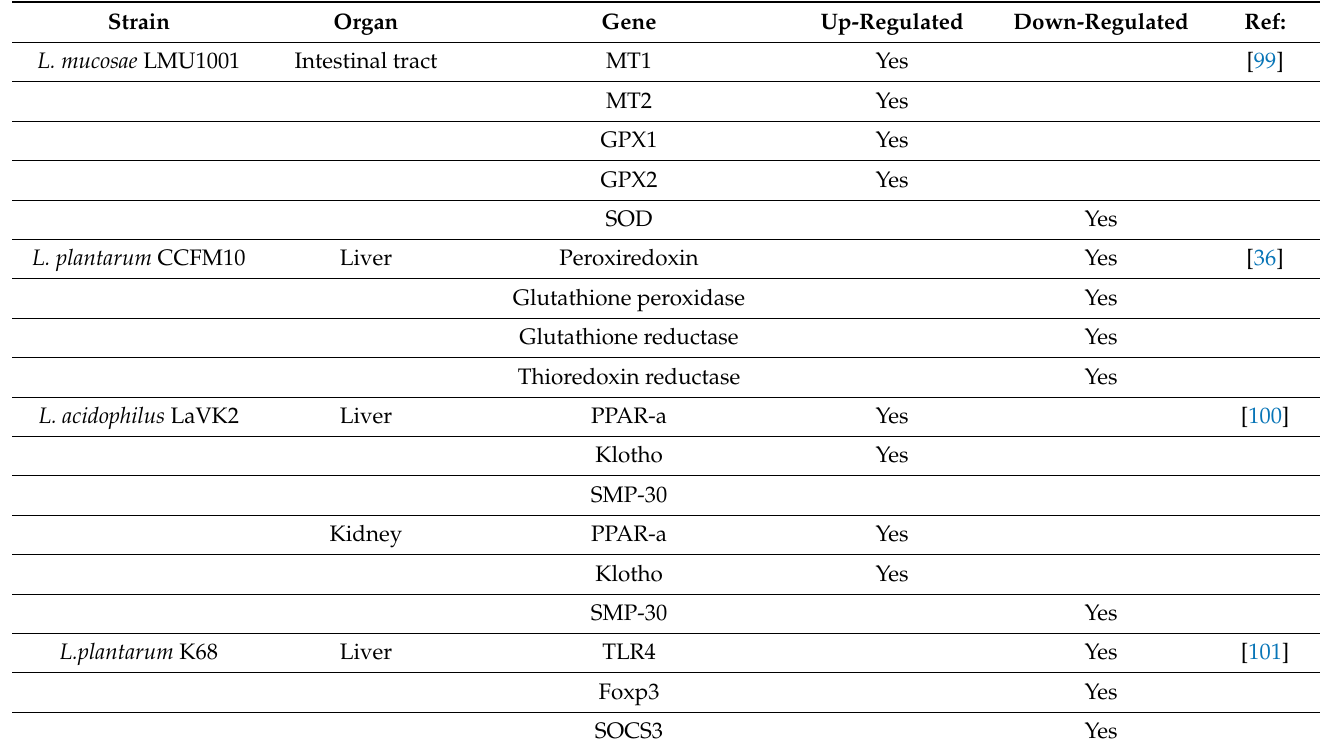
Table 2. Impact of administration of different Lactobacillus strains on gene expression in different organs by using mice model. Organ Gene Up-Regulated Down-Regulated